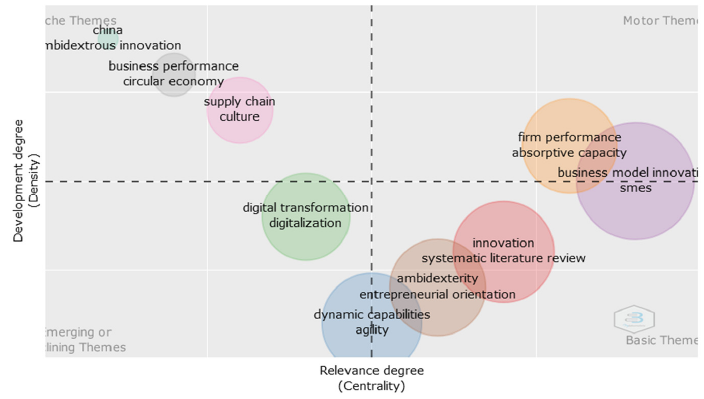
Figure 5. Thematic map of authors’ keywords. Source: Scopus/Biblioshiny.